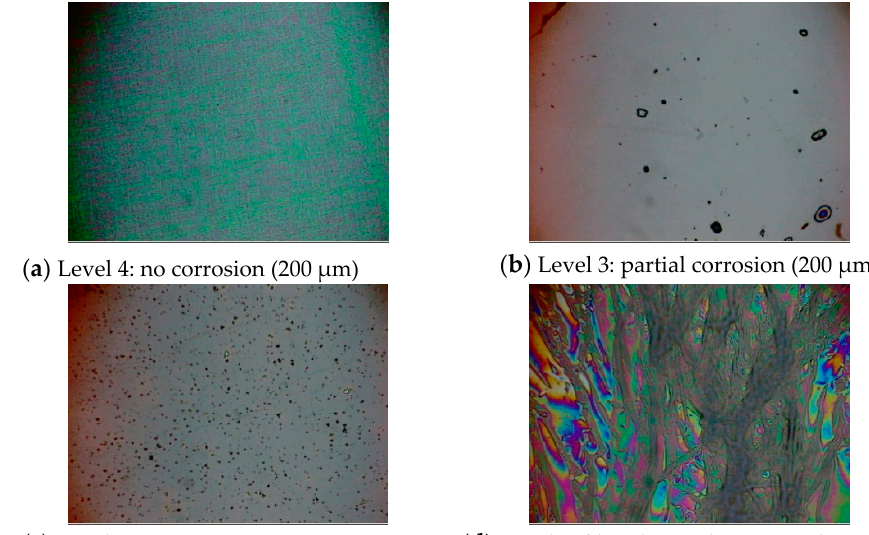
Figure 5. Typical optical microscopic images of samples evaluated as levels 4, 3, 2, and 1 in the anti-corrosion test of amorphous carbon films.